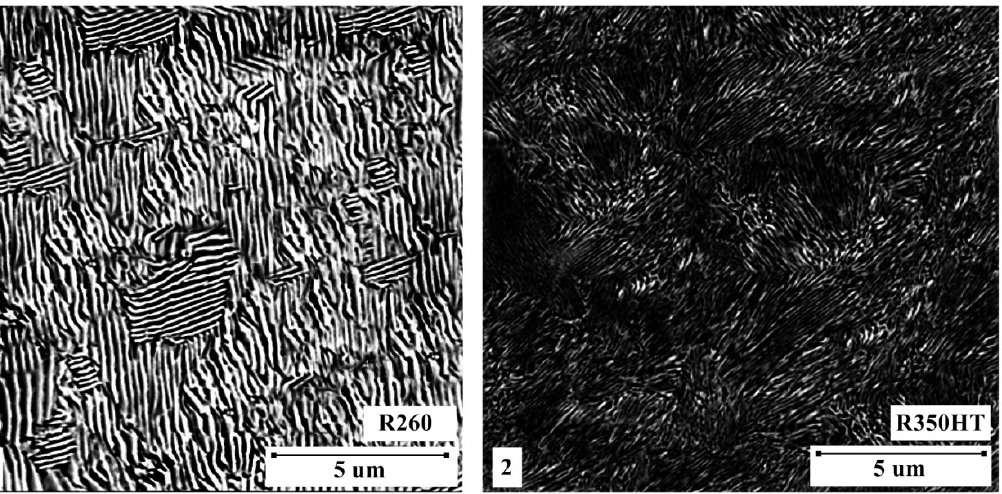
Figure 6. Micrographs taken with a scanning microscope at ×5000 magnification: 1 —samples of the R260 rail, 2 —samples of the R350HT rail, various pearlite colonies composed of alternating layers of ferrite and cementite are visible.